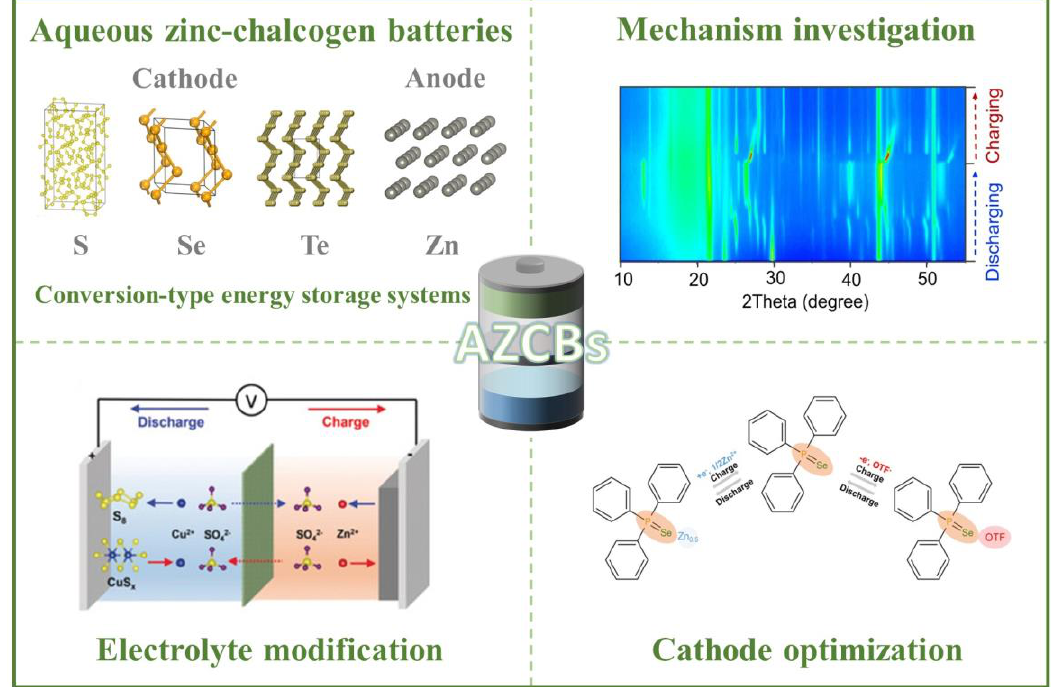
Figure 2. A comprehensive review of the research on AZCBs (reproduced with permission from Ref. [66]. Copyright 2020 WILEY-VCH. Reproduced with permission from Ref. [67]. Copyright 2019 WILEY-VCH. Reproduced with permission from Ref. [68]. Copyright 2022 Springer Nature. Repro-